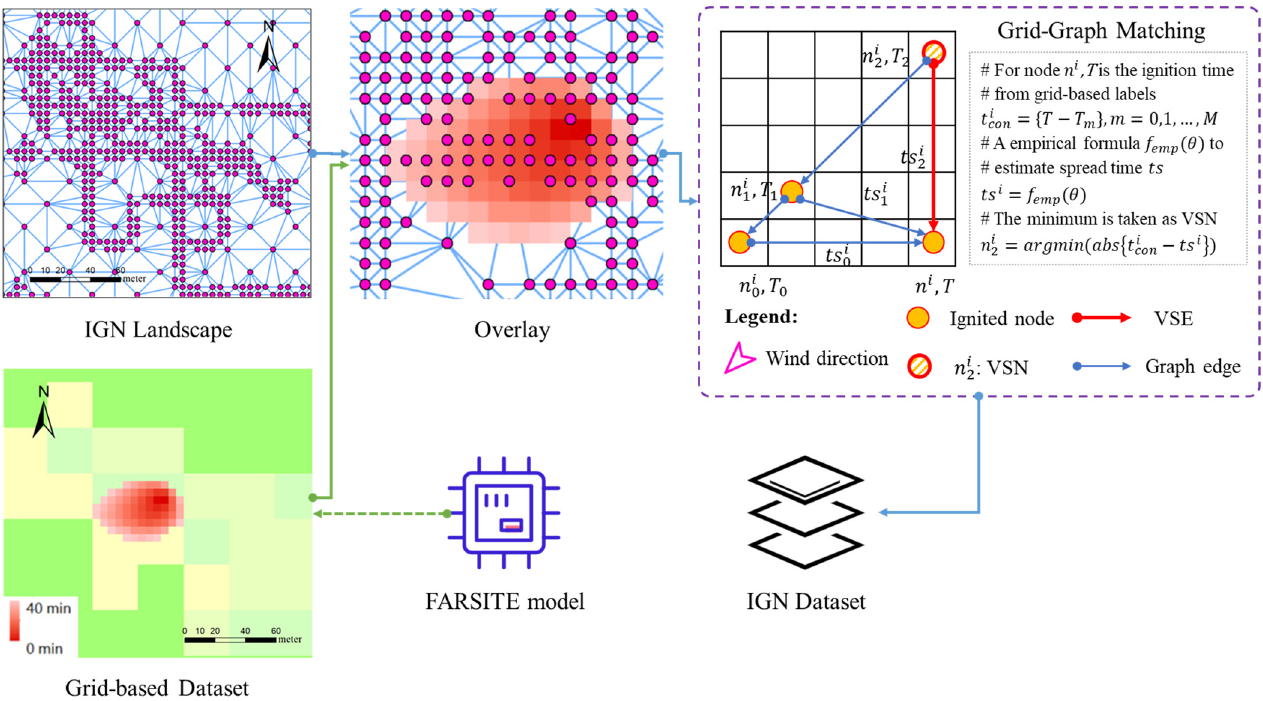
Figure 4. Construction process of IGN dataset with Grid-Graph matching method.